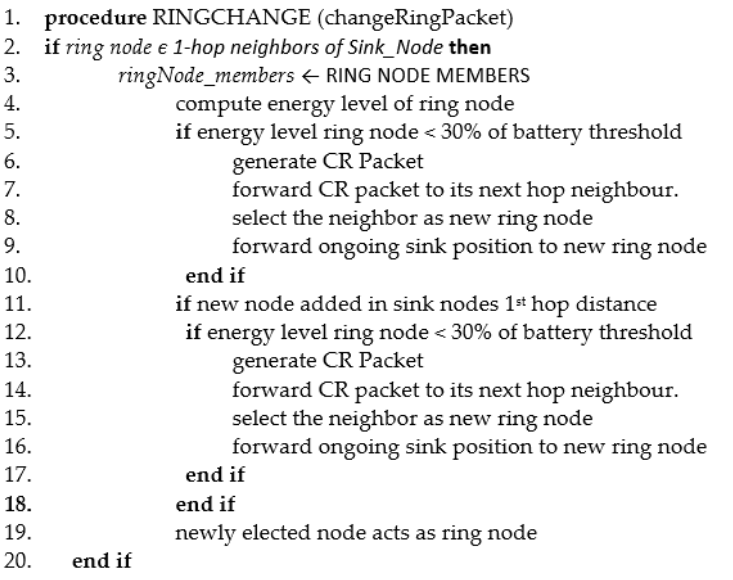
Figure 9. A ring change scenario .